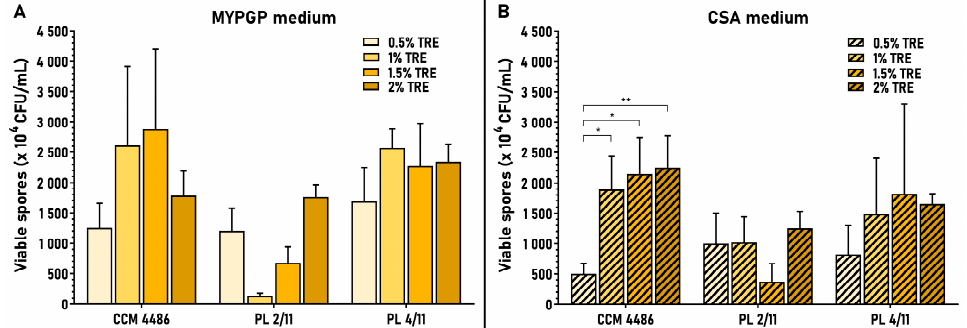
Figure 4. Effect of different trehalose concentrations on sporulation of P. larvae ERIC II strains. Spore yields obtained on MYPGP or CSA plates with 0.5–2% concentrations of trehalose are depicted as the mean ± SEM. Statistical significance of data considering the yields obtained at 0.5% trehalose as a control is shown (* p < 0.05, ** p < 0.01). Individual data sets represent results from 3–5 spore cultivation replicates at 1% and 1.5% trehalose and 6–9 replicates at 0.5% and 2%